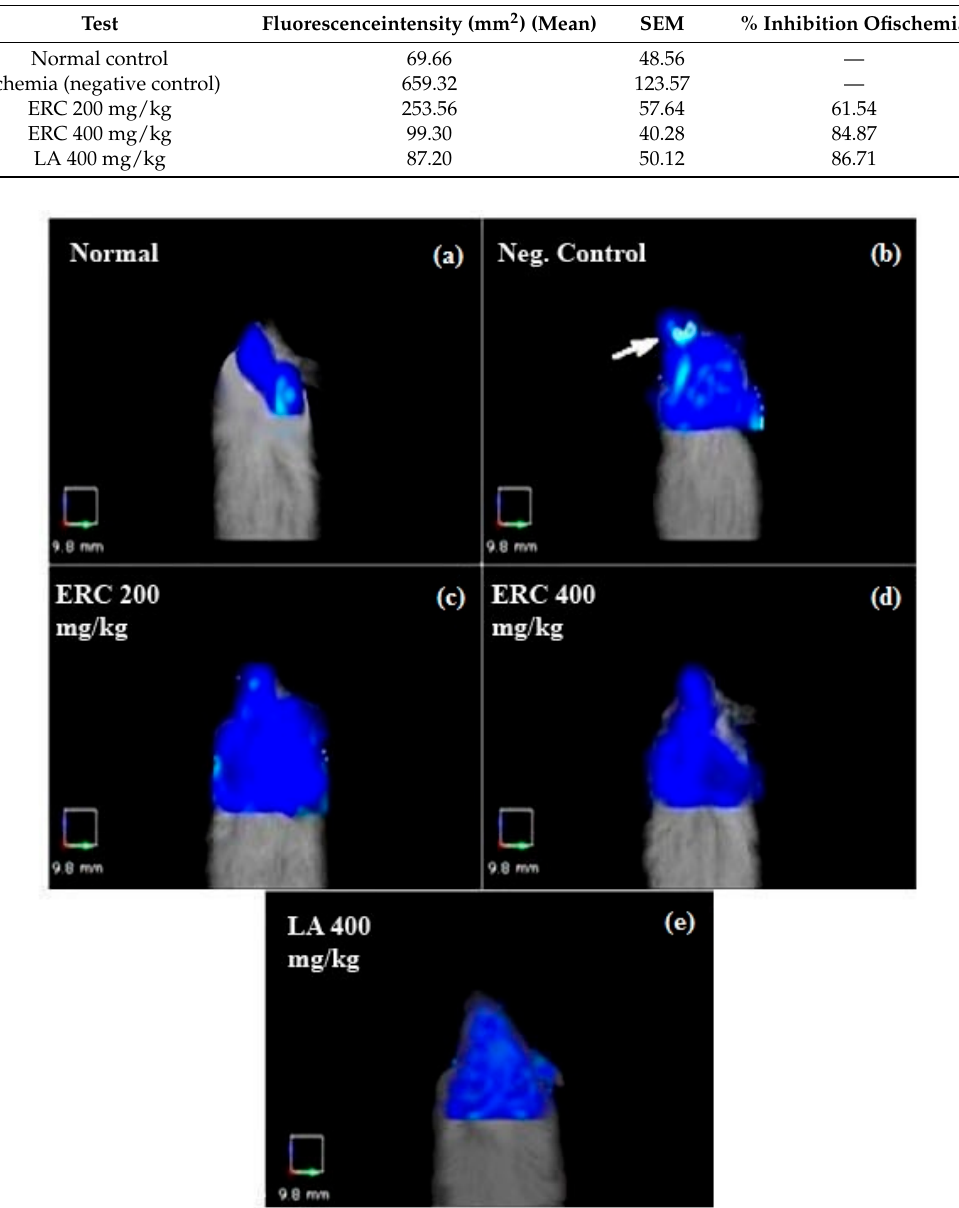
Figure 2. Fluorescence molecular tomography images without the region of interest (ROI). In this figure, the ROI area was not selected, but the differences in fluorescence intensities between the negative control ( b ) and the treated groups ( c – e ) is obvious. The negative control was the animal with induced ischemia at the left optic nerve/eye. The untreated normal animal was used as the positive/normal control ( a ). ProSens 750 was used as the inflammatory (cathepsin) fluorescent probe. In the group treated with 400 mg/kg body weight of ERC ( d ) and LA ( e ), the cathepsin fluorescence signal was significantly lower than that of the negative control.